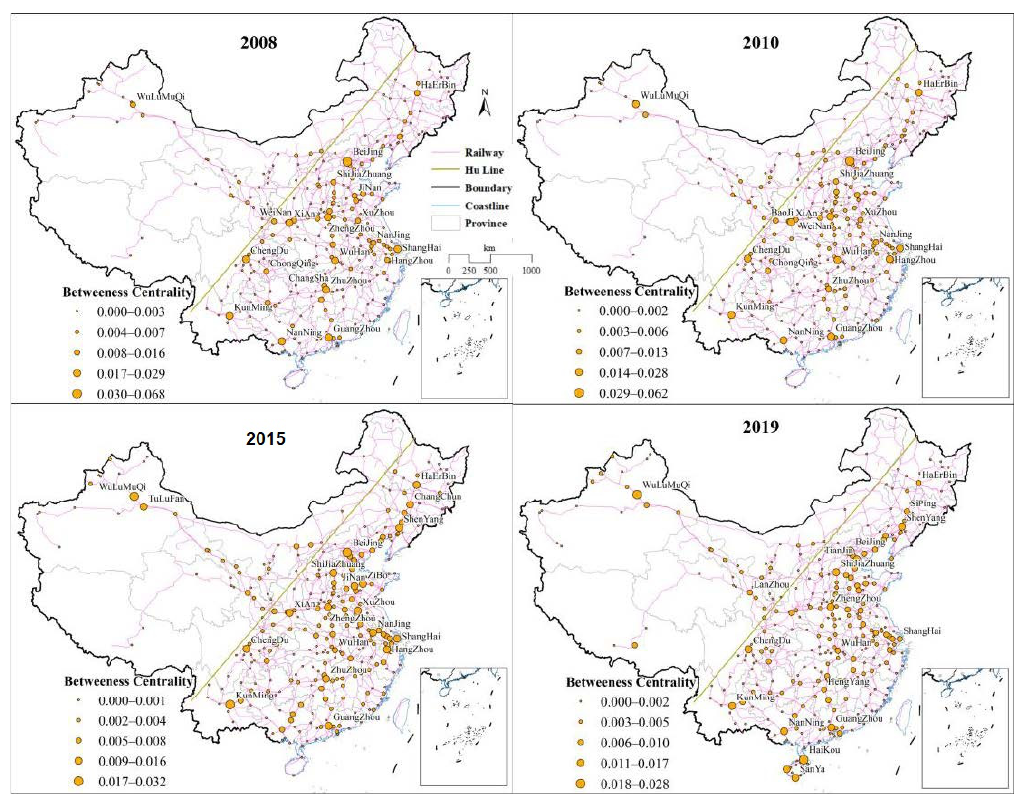
Figure 3. The maps of betweenness centrality values in different